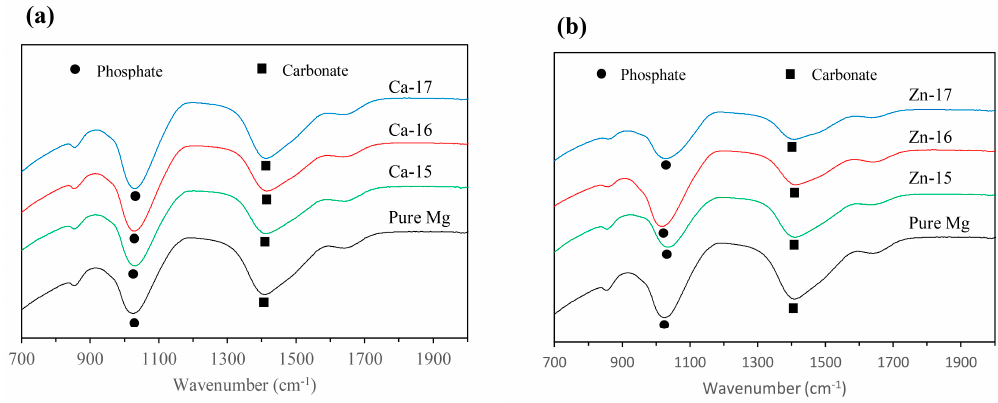
Figure 5. Fourier transform infrared (FTIR) spectra of: ( a ) Ca-ion; and ( b ) Zn-ion implanted magnesium after potentiodynamic polarisation in SBF.